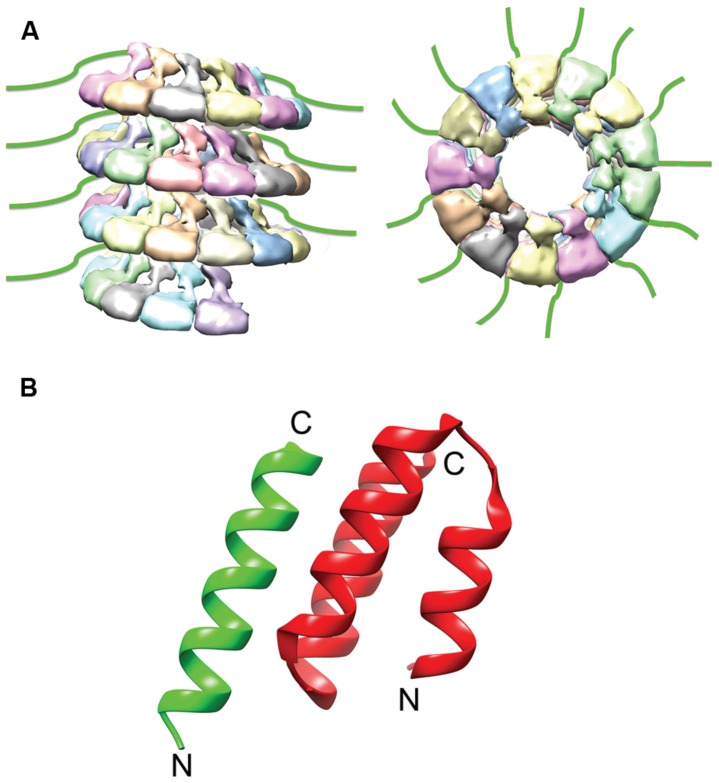
NTail and NTail–PCTD Interaction. (A) The extreme C-terminal region of N, NTail (green), is highly flexible and extends outward from the assembled NC (Jensen et al., 2011). (B) A short helix in NTail (green) is involved in binding the C-terminal NC binding domain of P (red). The N- and C- termini are labeled (PDB code 1T6O; Kingston et al., 2004a). The NC model was modified from the mumps NC structure (EMDataBank access code EMD-2630; Cox et al., 2014).